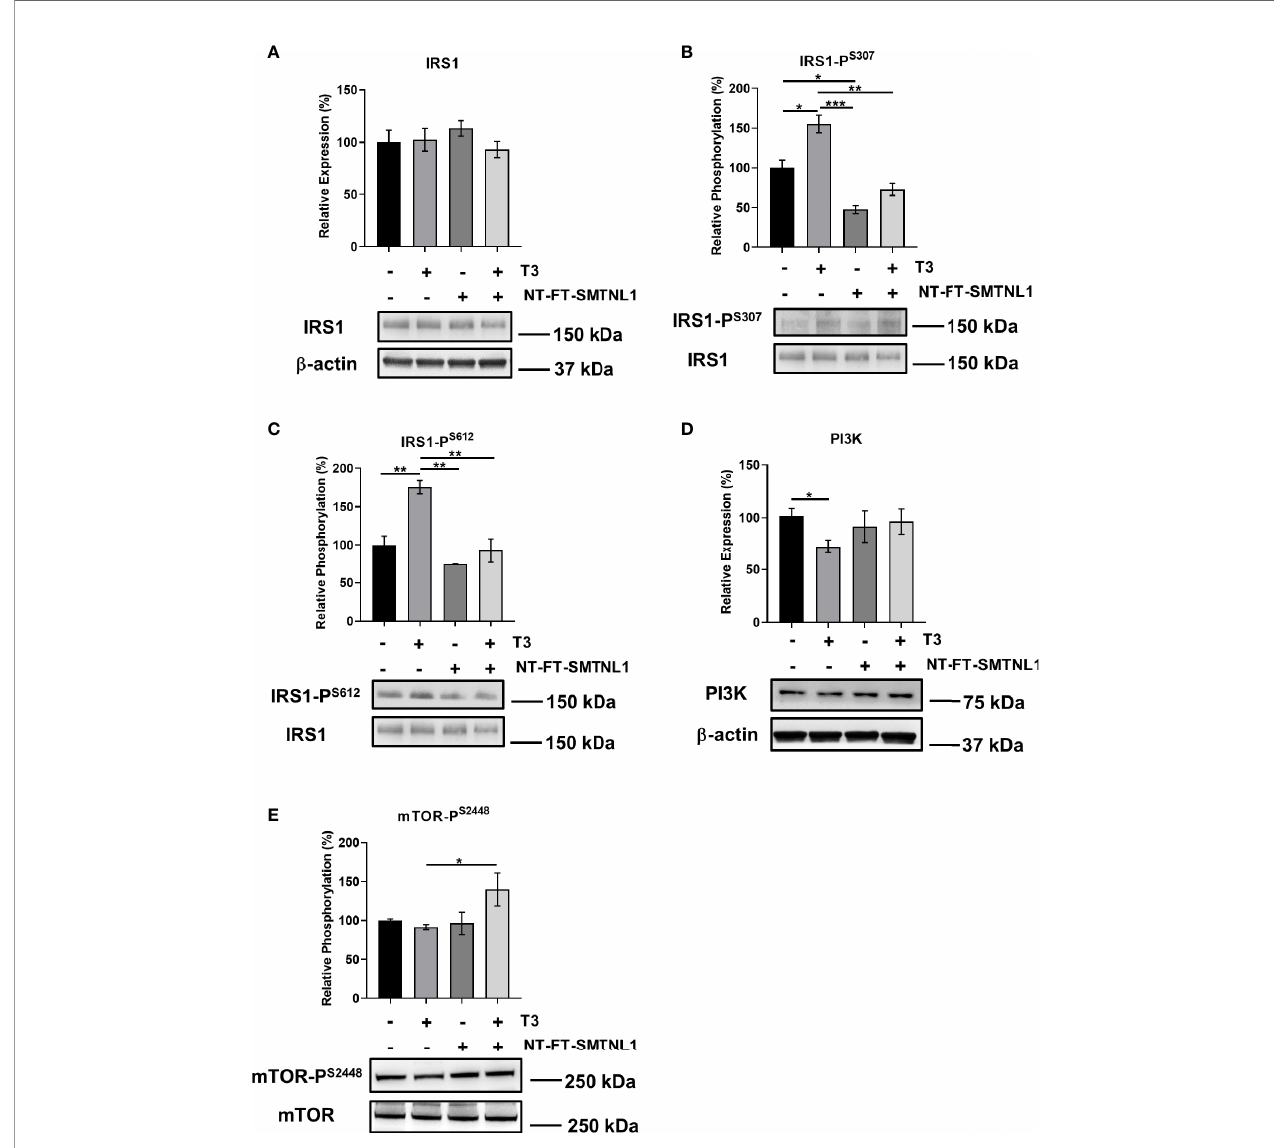
FIGURE 6 | T3 overload and SMTNL1 overexpression affect the phosphorylation of key members of insulin signaling. (A – E) Empty vector or NT-FT-SMTNL1- transfected myoblasts were differentiated with a simultaneous 72-hour T3 treatment starting from Day 4. Proteins from whole-cell lysates were analyzed by Western blot using anti-IRS1 (A) , anti-IRS1-P S307 (B) , anti-IRS1-P S612 (C) , anti-PI3K (D), and anti-mTOR-P S2448 (E) . Values represent n=3-6, mean +/- SEM. Data were normalized to the empty vector-transfected control. Groups were compared using One-way ANOVA and Tukey ’ s post hoc test, p < 0.05 (*), p < 0.01 (**), p < 0.001